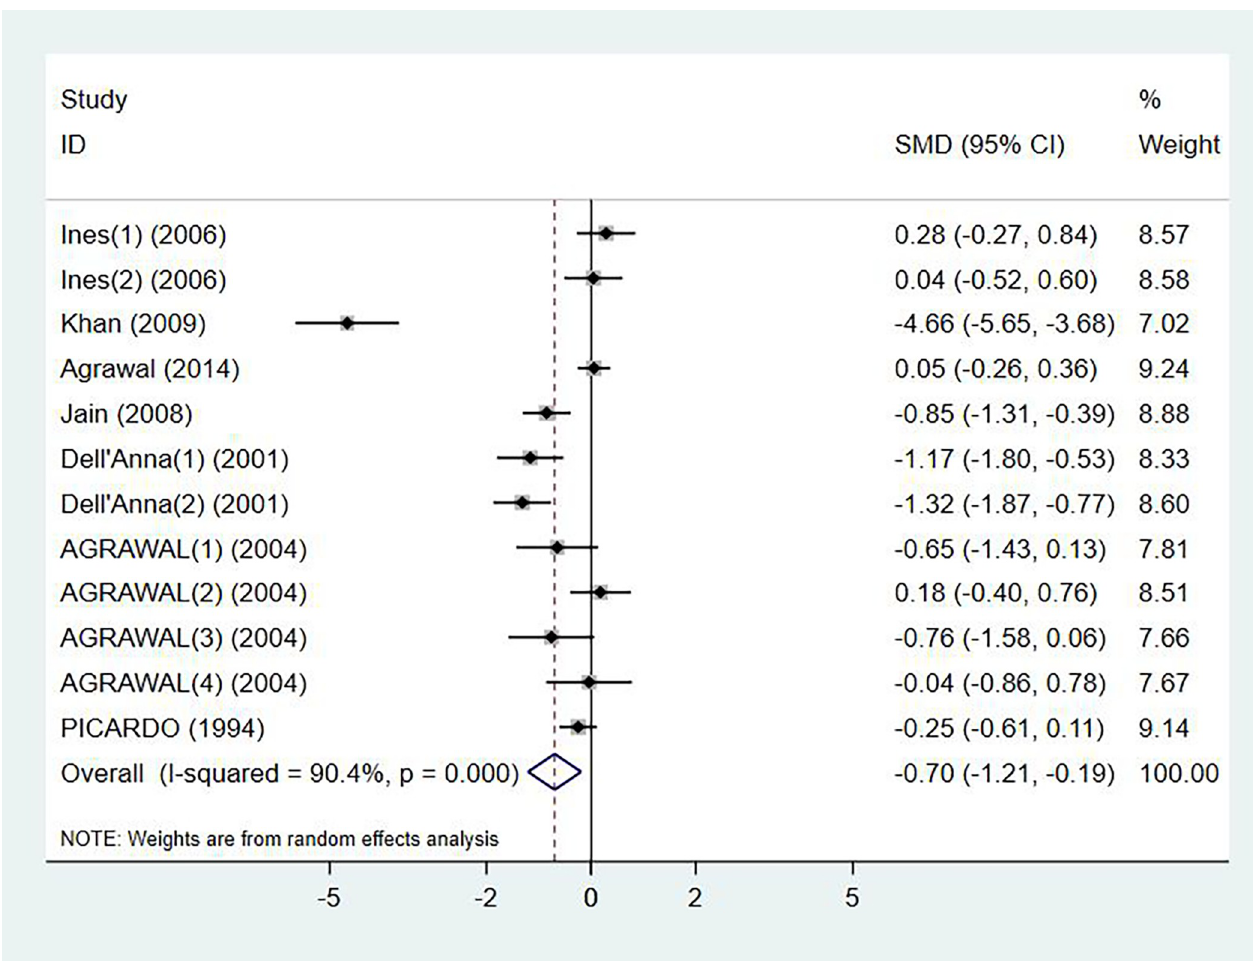
(Fig 3). No publication bias was detected by Egger’s test (p = 0.058).